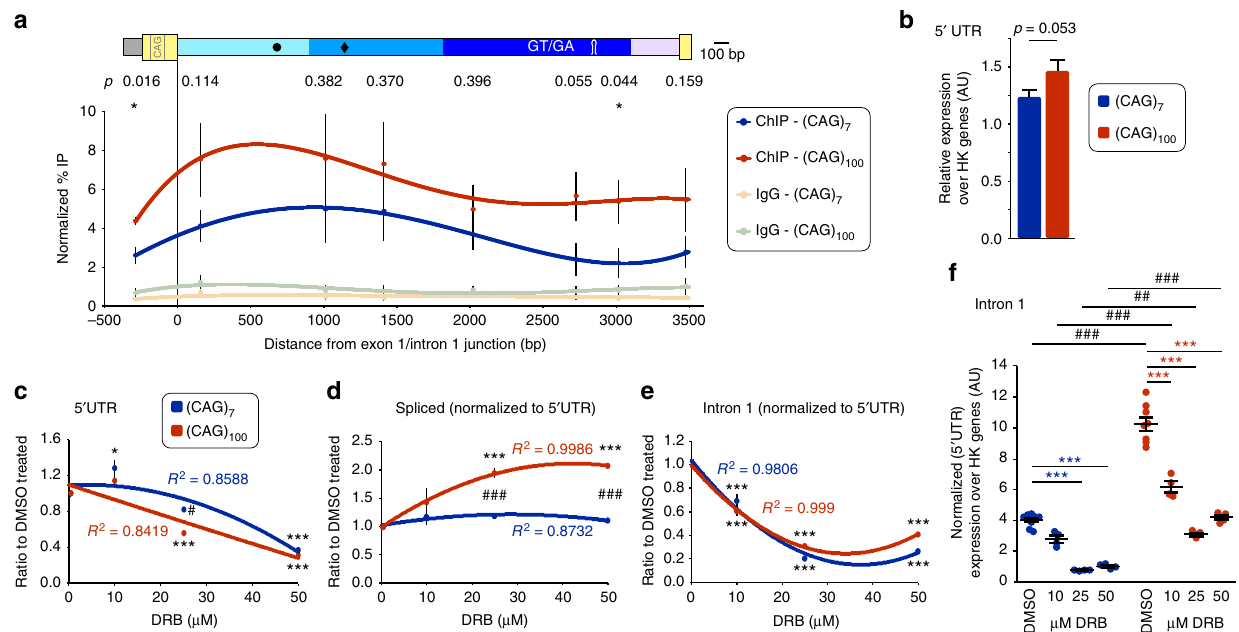
Fig. 5 PolII transcriptional speed modulates the amount of incomplete splicing of Htt . a Chromatin immunoprecipitation of minigene associated RNA PolII. The schematic shows the position of the qPCR assays on the minigene (to scale). Data are mean ± s.e.m.; n ≥ 5 independent ChIPs/CAG-length, Student ’ s t -test. Regression fi ts were calculated from the individual data points. CAG-length: * p < 0.05. Data represents % recovered PolII normalized to input transcript levels (see also methods section). b 5 ′ UTR levels in the (CAG) 7 or (CAG) 100 expressing minigene lines. Data are mean ± s.e.m.; n ≥ 22 independent experiments, Student ’ s t -test. c – f 5,6-dichlorobenzimidazole 1- β - D -ribofuranoside (DRB) treatment. Data are mean ± s.e.m.; n ≥ 4 independent treatments/CAG-length/concentration, two-way ANOVA with Tukey post hoc test. Regression fi ts were calculated from the individual data points. Treatment: * p < 0.05, *** p < 0.001. Treatment x CAG-length # p < 0.05, ## p < 0.01, ### p < 0.001. c – e Data are shown as the ratio to the respective DMSO treated sample. c 5 ′ UTR levels indicate either less transcription of the minigenes at higher DRB concentrations, cytotoxicity at higher DRB concentrations, or a combination of both. d Normalized spliced exon 1-exon 2 levels were signi fi cantly higher at high DRB concentrations in the (CAG) 100 versus the (CAG) 7 lines. e The reduction of intron 1 containing sequences was very similar for both CAG repeat lengths. f Treatment with DRB resulted in a signi fi